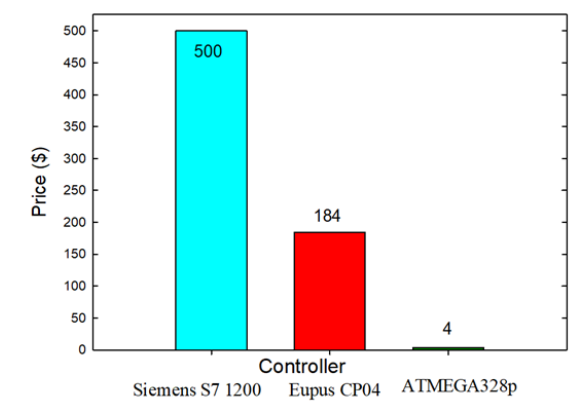
Fig. 3. Cost in US dollars, other PLCs vs ATMEGA328p